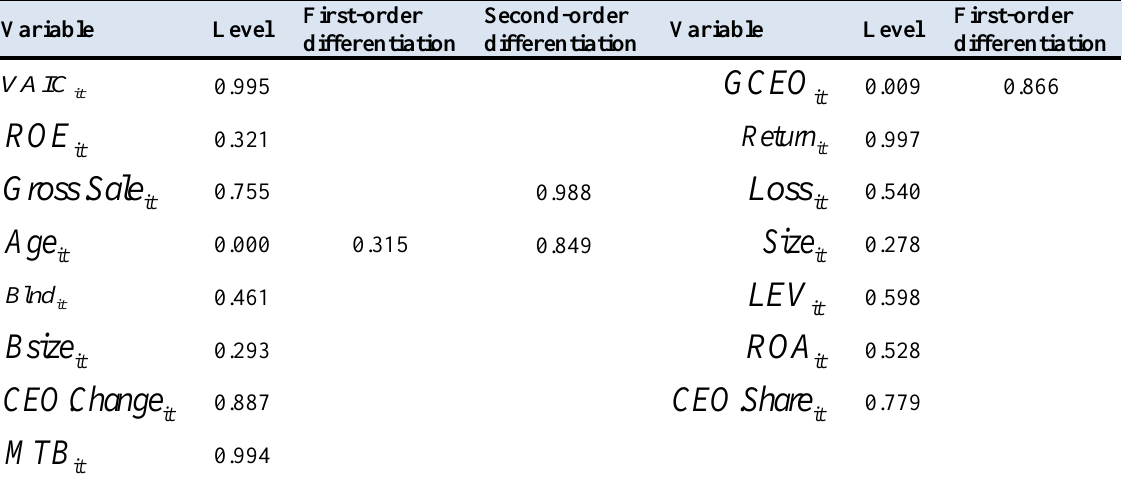
Table 5. The results of the Hadari unit root test for the Iraqi data